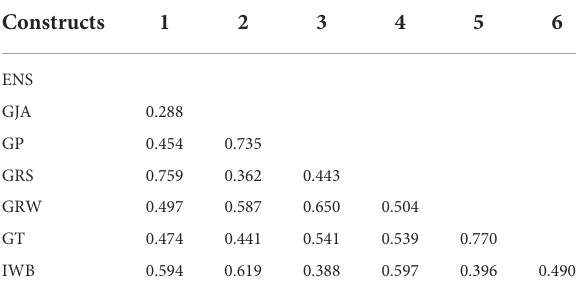
TABLE 2 Discriminant validity Heterotrait-Monotrait ratio (HTMT).